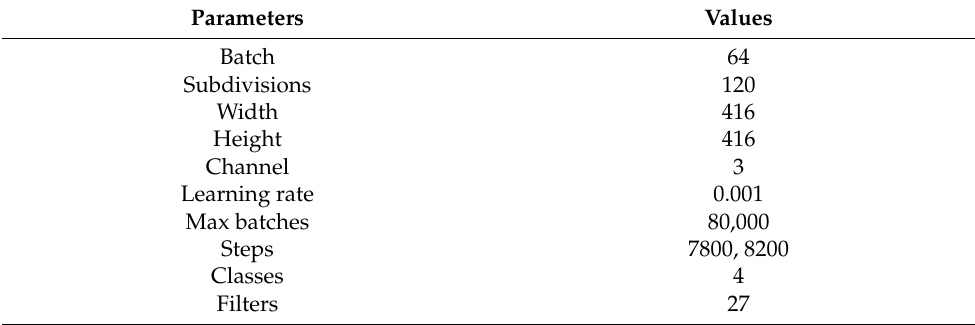
Table 3. Parameters of the custom configuration file.